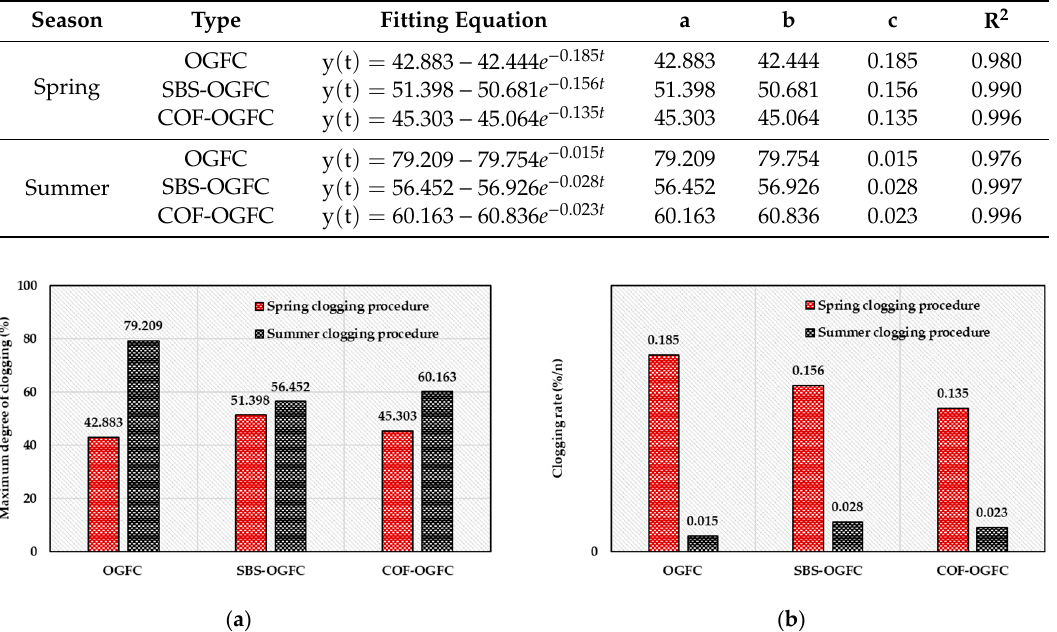
Table 11. Spring-thawing clogging model and model parameters of three mixtures.